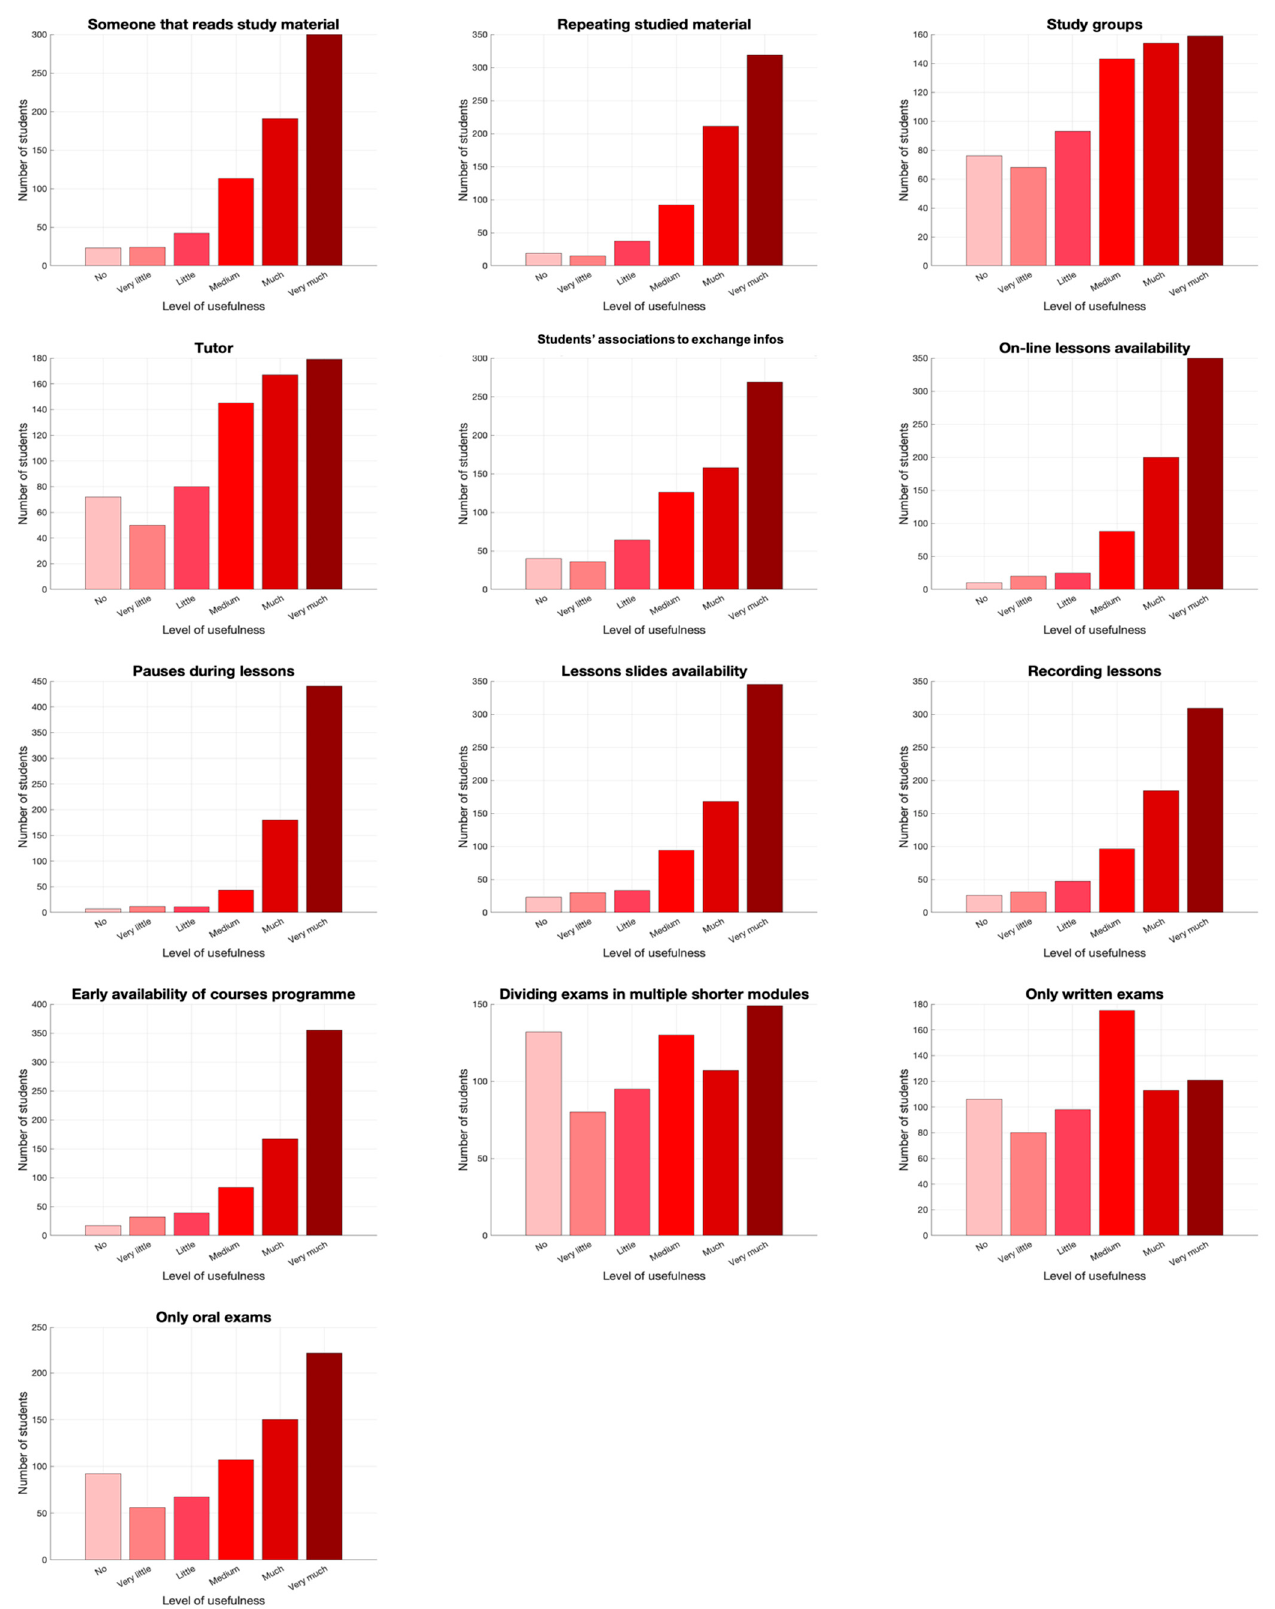
Figure A3. Histograms of the scores given by dyslexic students to the usefulness of each supporting strategy present in the questionnaire.